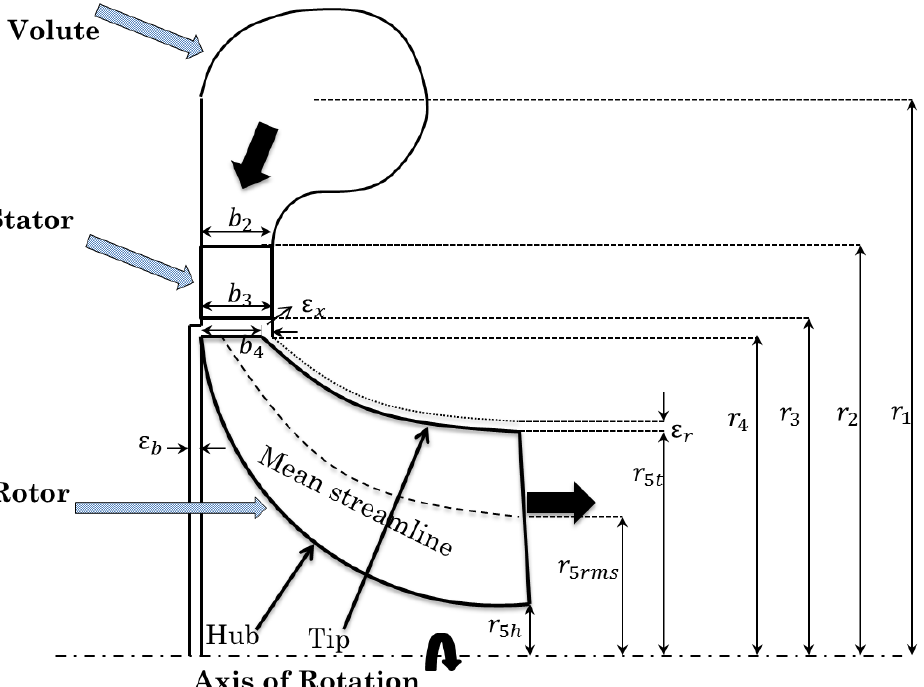
Figure 3. Meridional view of the turbine stage.